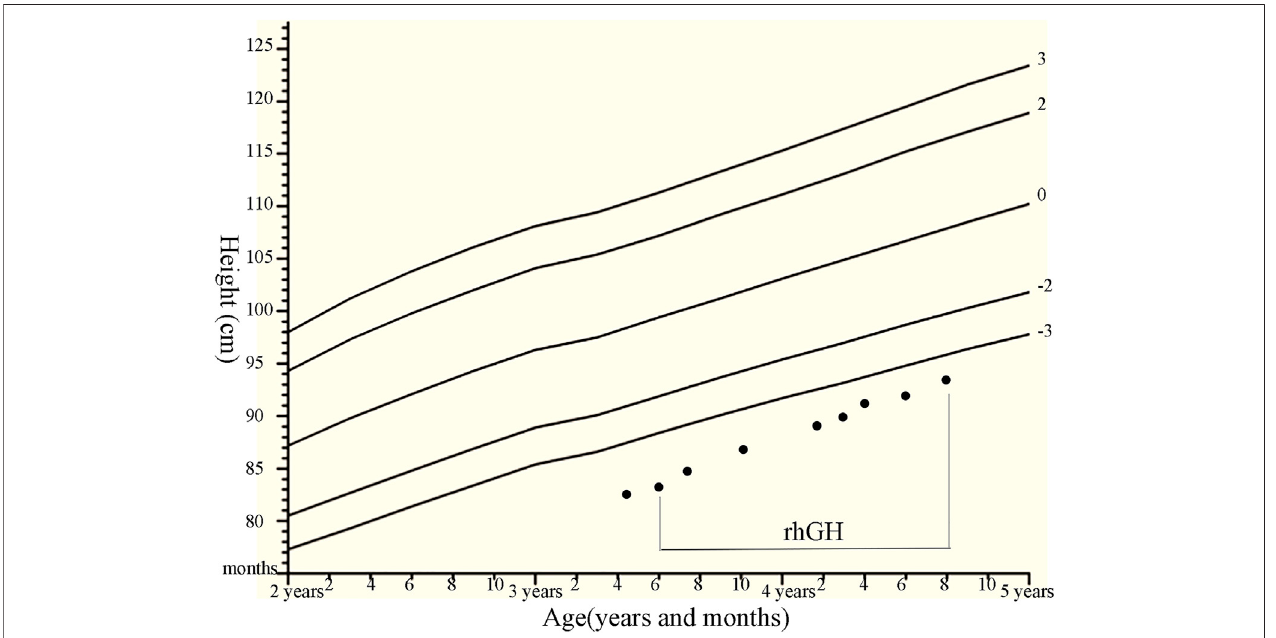
FIGURE 2 | Growth chart of the patients with compound heterozygous NPR2 mutations (c.1112G > A and c.2887+2T > C) with the rhGH therapies. We plotted the height on standardized growth charts for Chinese children and adolescents aged 0 – 18 years (Li et al., 2009), and evaluate rhGH treatment ef fi cacy for our